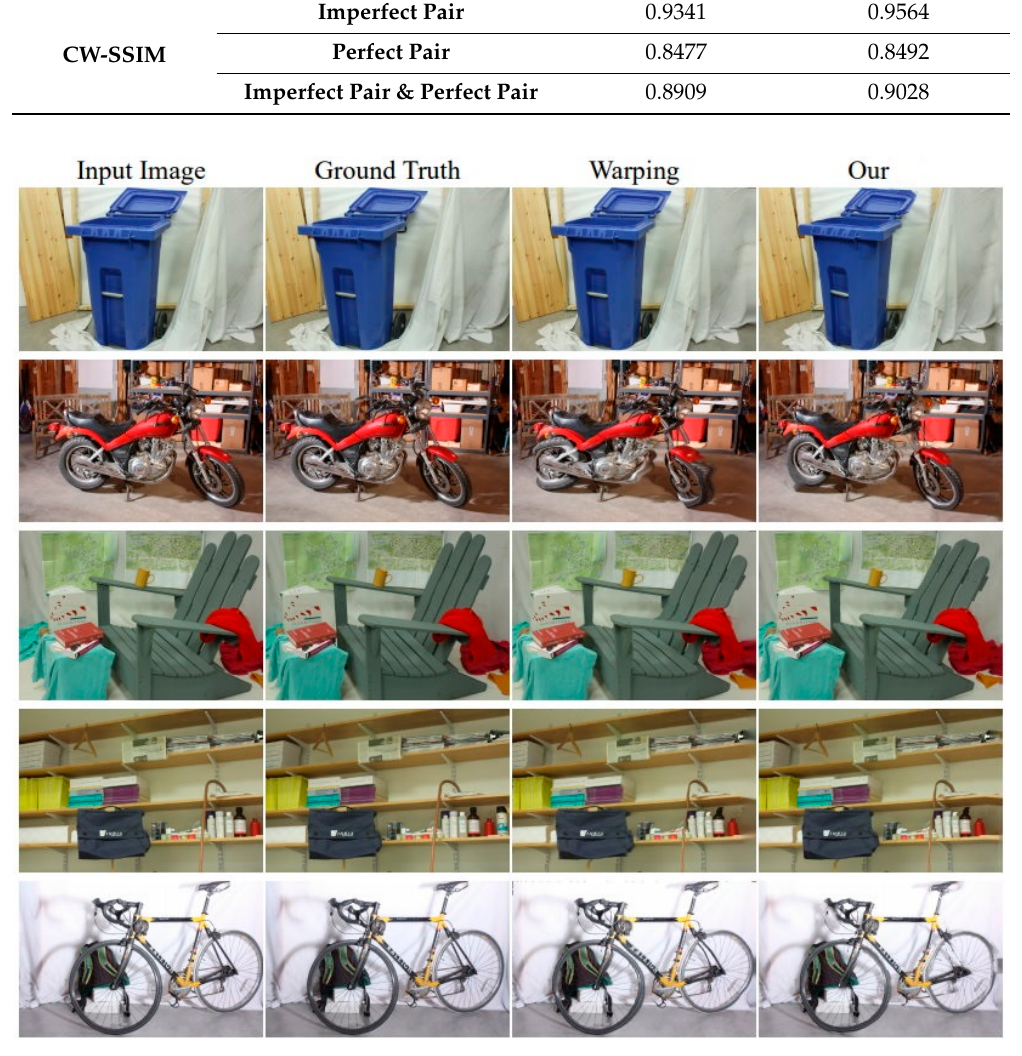
Table 1. Average values of imperfect- and perfect-pair images.